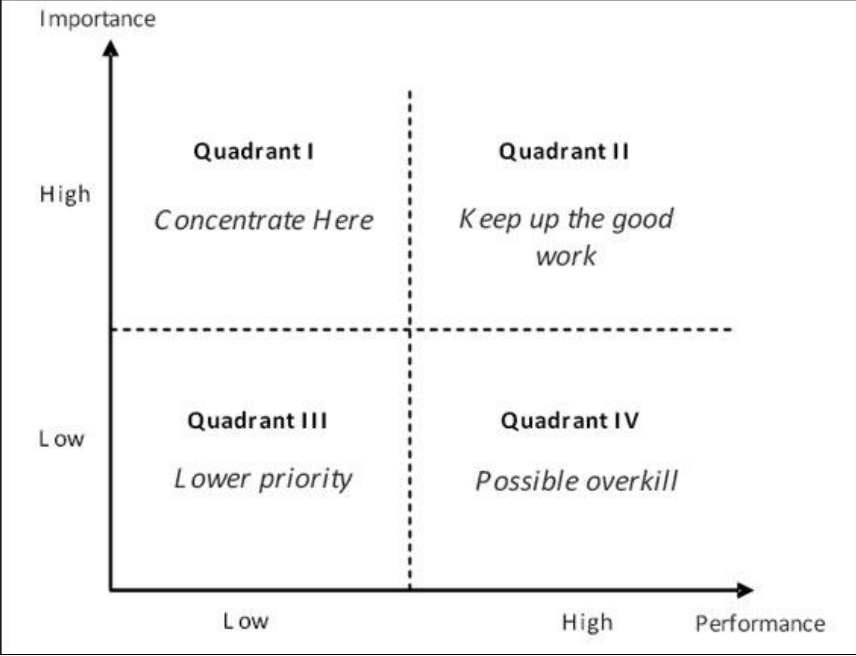
Fig. 1 Importance-Performance Matrix (Adapted